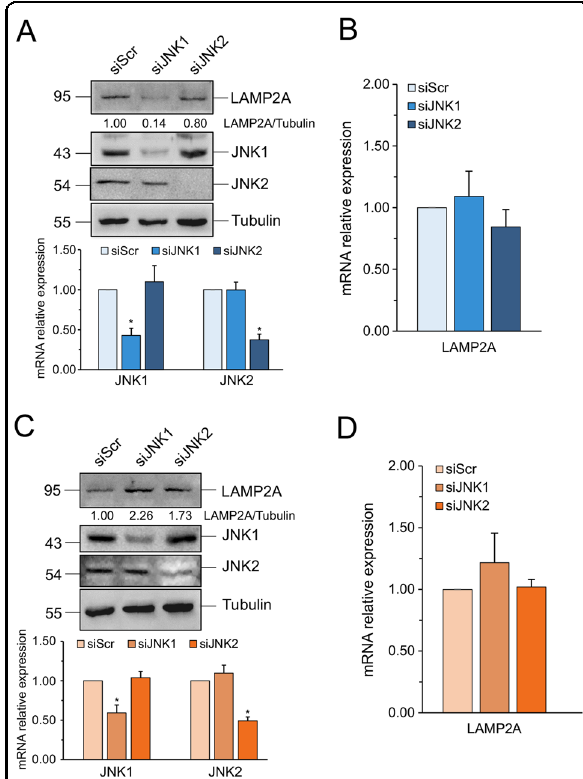
Fig. 4 JNK1 but not JNK2 regulates LAMP2A. A – C (Upper panel) Western blot analyses of LAMP2A expression Hep3B ( A ) and HuS cells ( C ) transfected with siScr or siRNA speci fi c for either JNK1 or JNK2. (Lower panel) Real-time qPCR analysis of JNK1 and JNK2 mRNA expression in Hep3B transfected with siScr or siRNA speci fi c for either JNK1 or JNK2. Data are expressed as mean ± SEM of n = 3 independent experiments. * p < 0.05 vs. siScr. B – D Real-time qPCR analysis of LAMP2A mRNA expression in Hep3B and HuS cells transfected with siScr or siRNA speci fi c for either JNK1 or JNK2. Data are expressed as mean ± SEM of n = 3 independent experiments. β -Actin was used as a reference gene. In Western blots, tubulin was used as a loading control, while JNK1 and JNK2 were used as control of knockdown speci fi city and ef fi cacy. Western blots are representative of n = 3 independent experiments showing similar